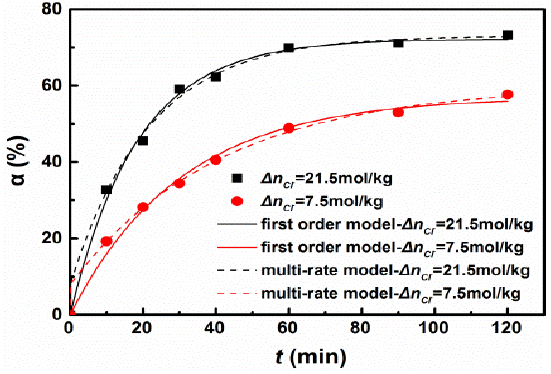
Figure 6. Degree of magnesium oxide hydration under an ultrasound condition.